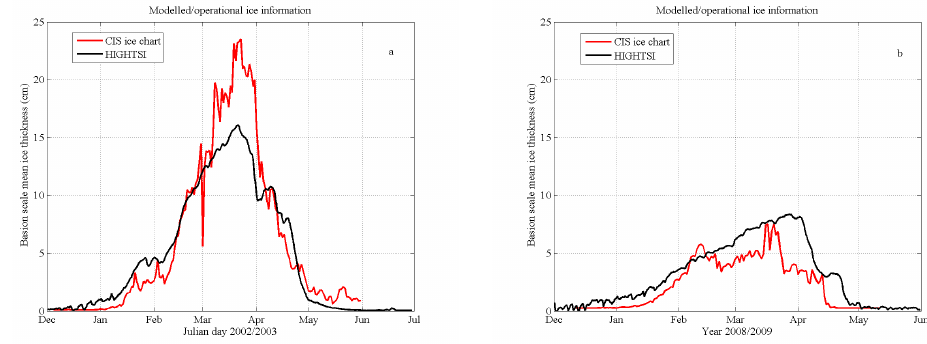
Fig. 5. Observed and modeled basin-scale mean ice thickness for winter season 2002–2003 (a) and 2008–2009 (b) .